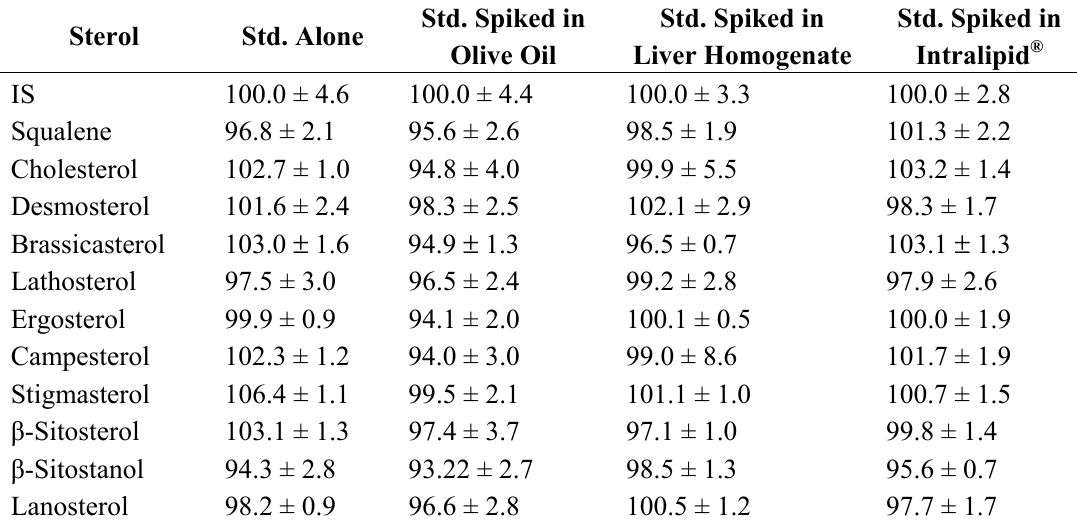
Table 2. Recovery results of the sterols in samples (%)